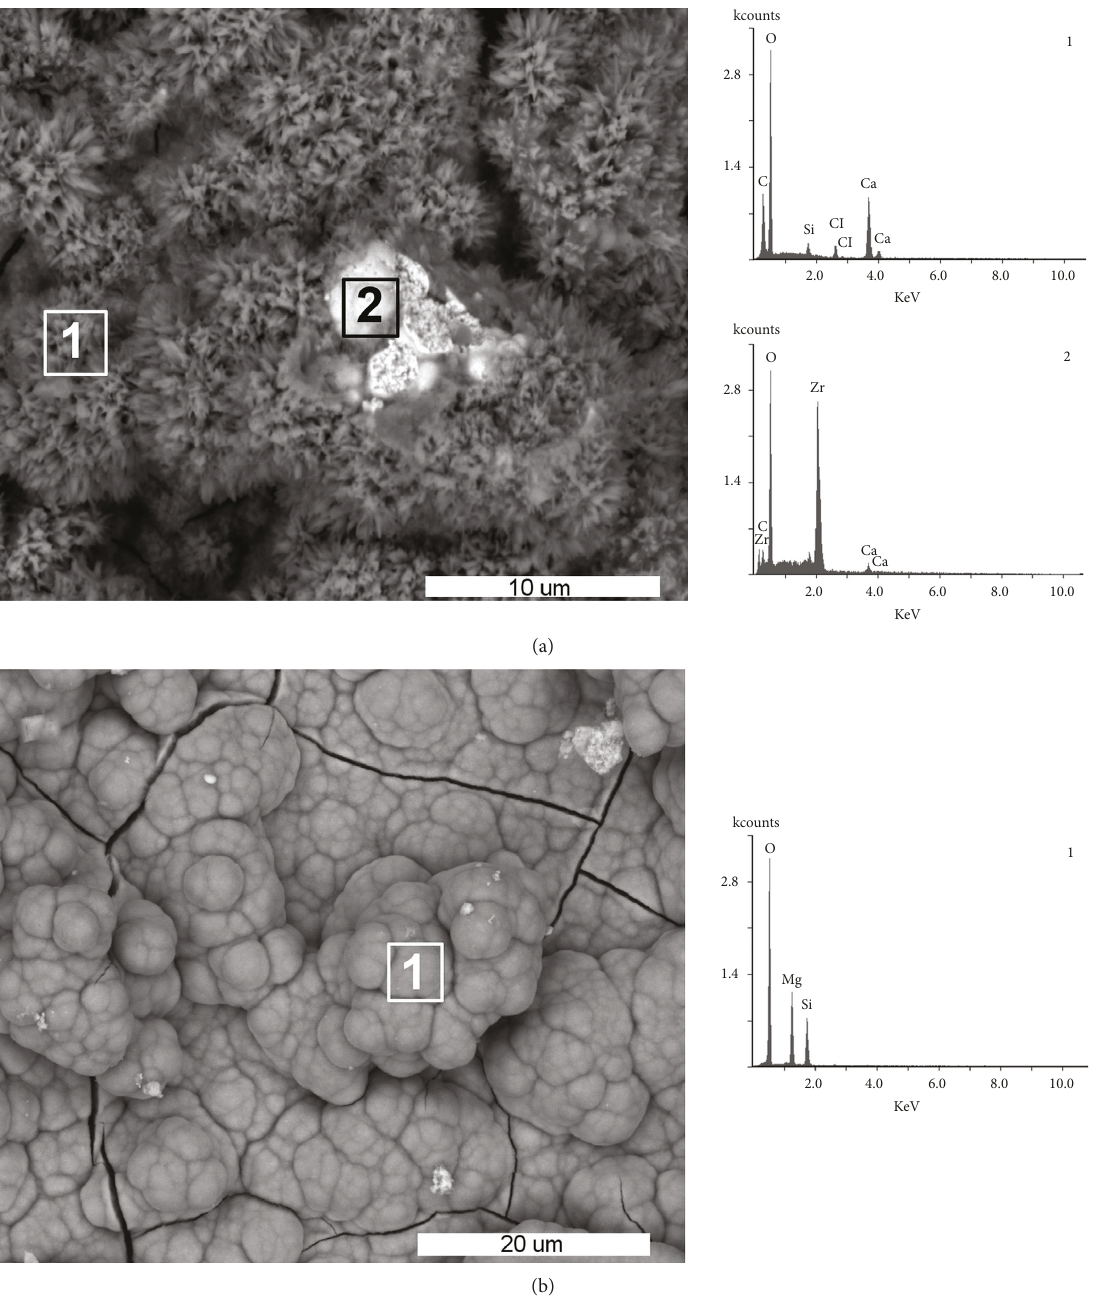
Figure 4: SEM images of B25Zr cement and EDS analyses: (a) before incubation in SBF (point 1 - cement surface, point 2 – grain of ZrO (b) after 28 days of incubation in SBF (point 1 – cement